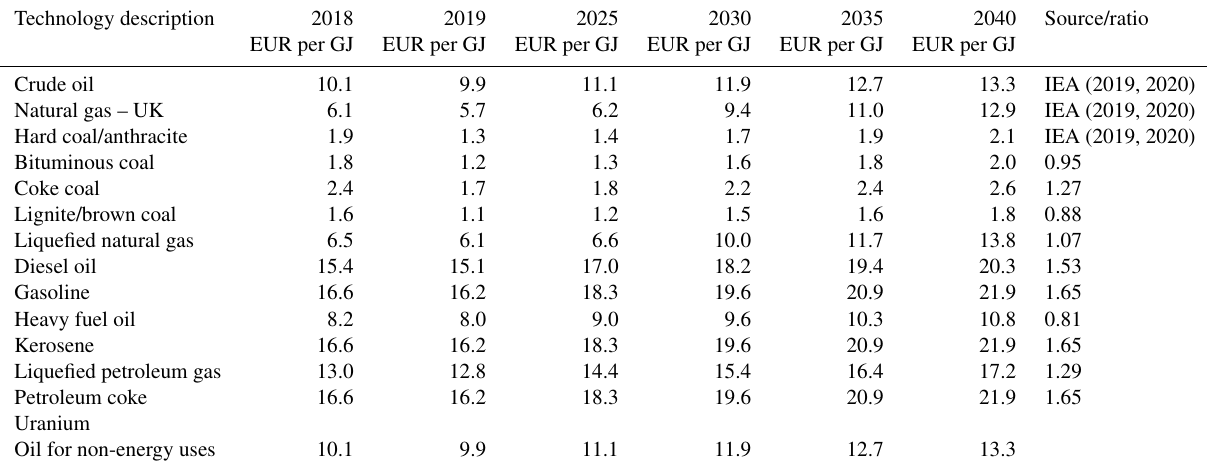
Table A1. Import fossil fuel commodity prices.